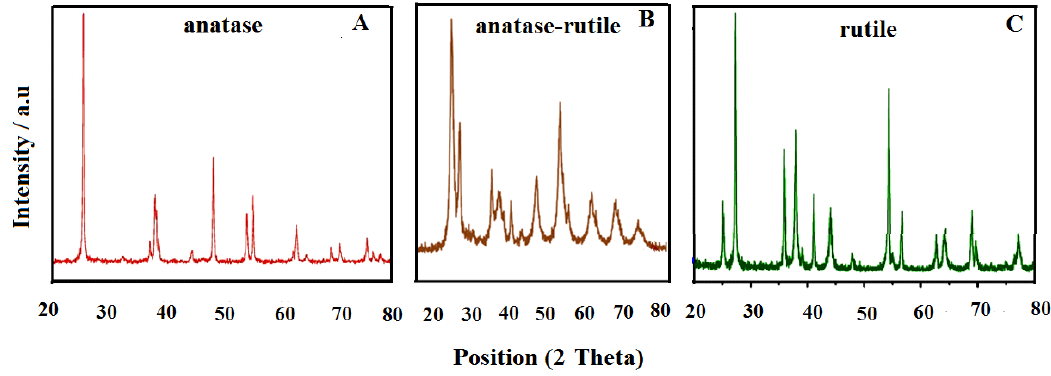
Fig. 1. Effect of different calcinating temperatures on the crystal structure of TiO